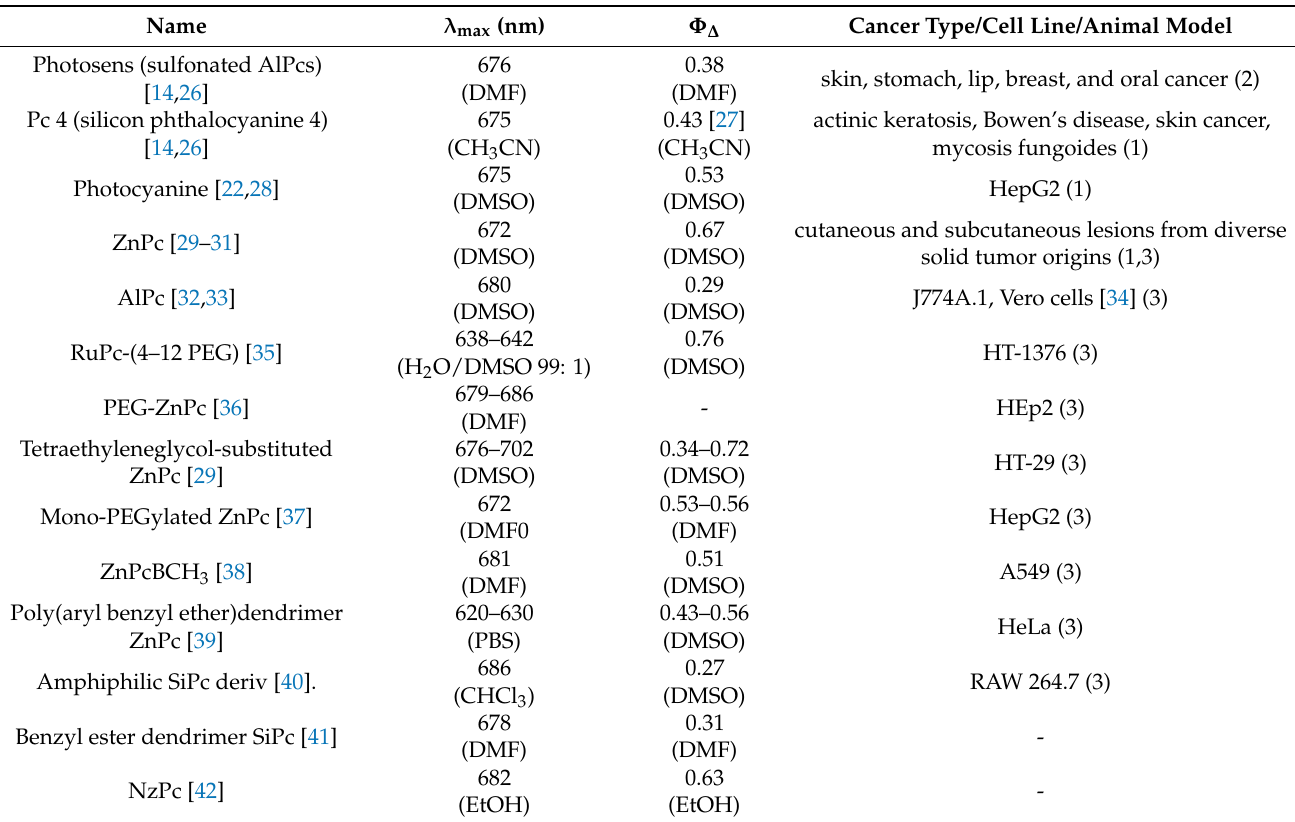
Table 1. The examples of Pcs used in PDT (1) currently under investigation in clinical trials, (2) already approved for clinical use, and (3) appeared in this review in polymeric nanoparticle delivery systems. Maximum absorption ( λ max ); 1 O 2 quantum yield ( Φ ∆